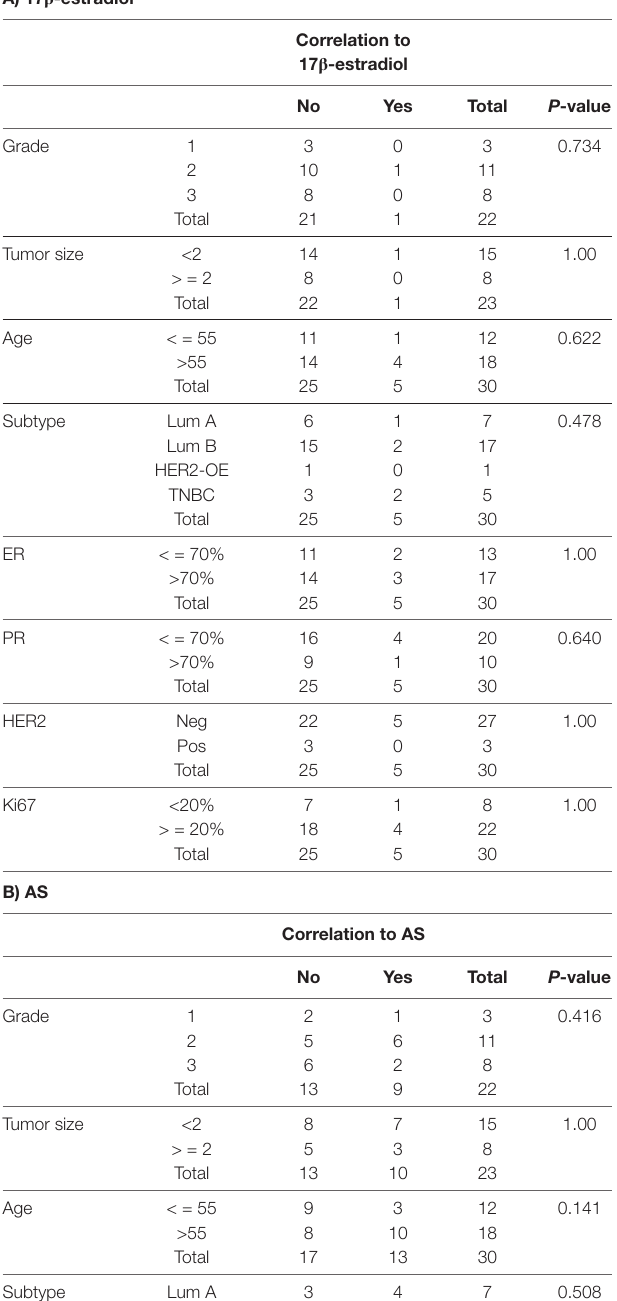
TABLE 1 | Among 30 samples, correlation of 17 β -estradiol and AS extract response to clinico-pathological features (significant response and high epithelial